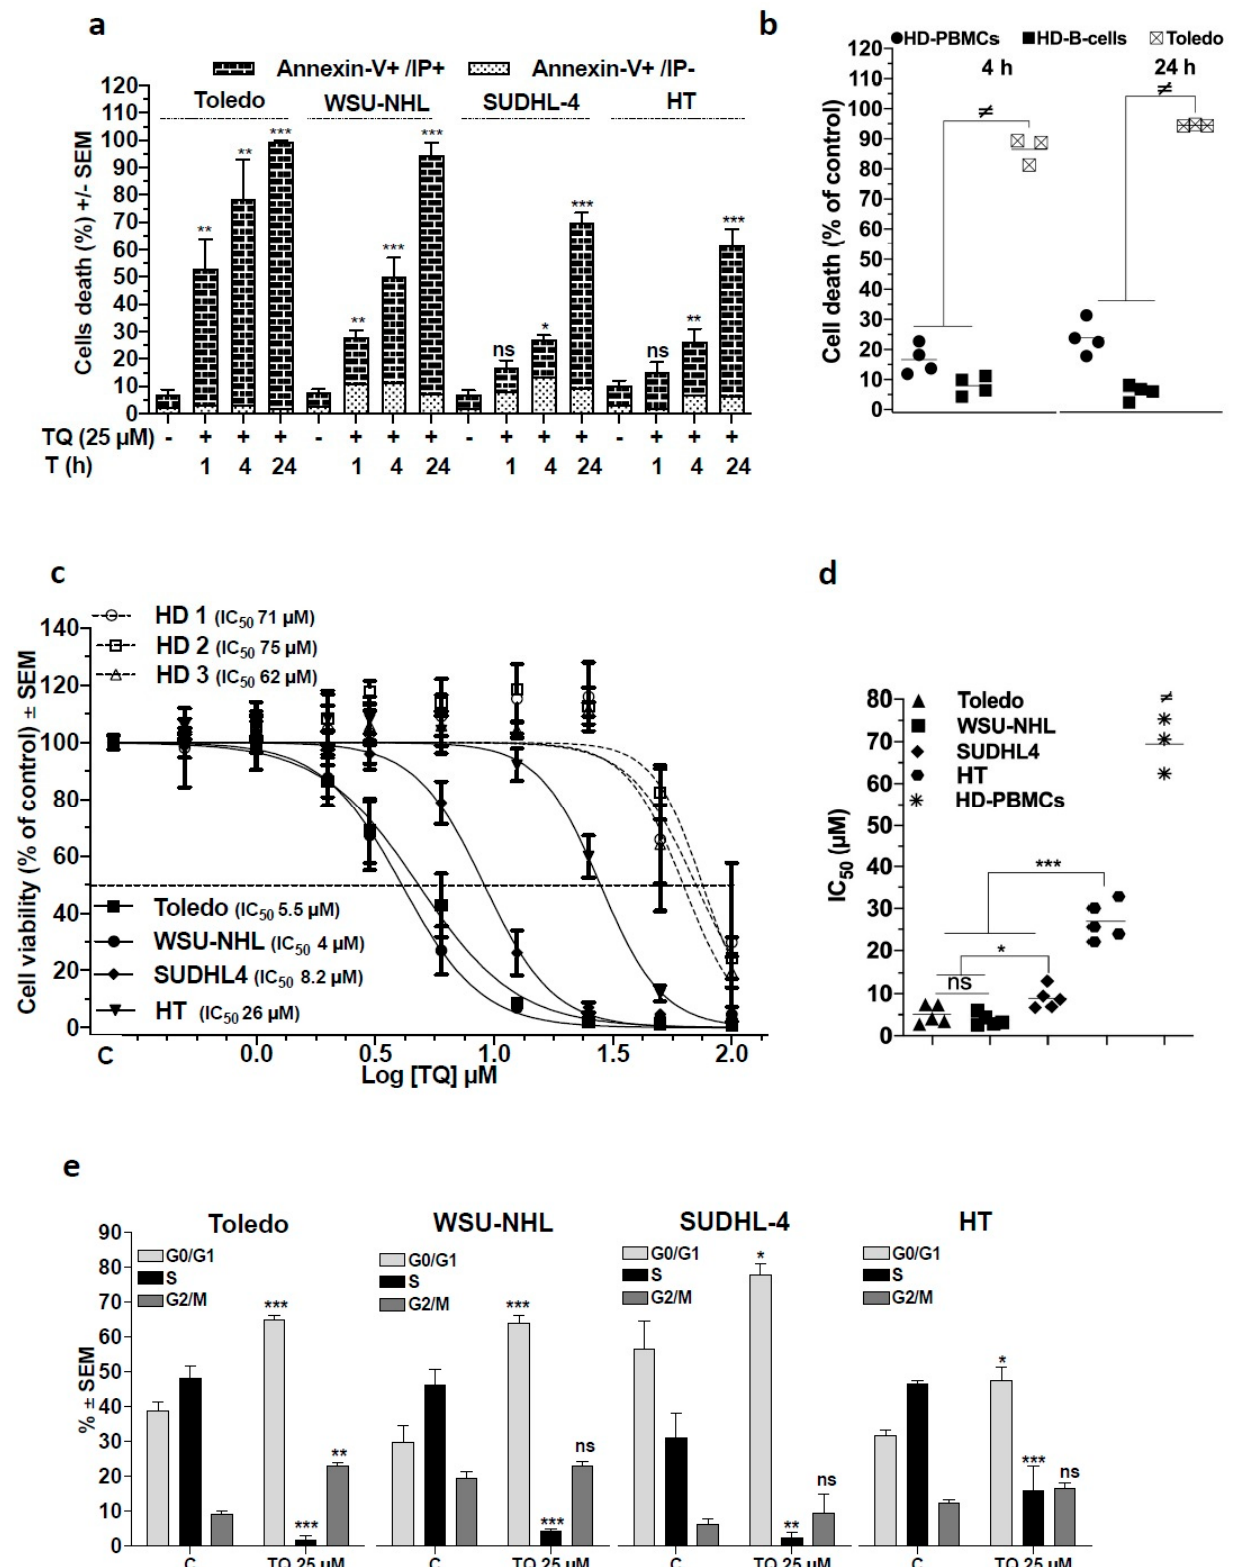
Figure 1. Effect of thymoquinone (TQ) on cell death and cell proliferation of GCB-DLBCL cell lines Toledo, WSU-NHL, SUDHL-4, and HT, and healthy hematological cells. ( a , b ) Cell death analysis: Cells were incubated in the presence of the drug vehicle (DMSO) or thymoquinone (TQ), then cell death was analyzed via flow cytometry after Annexin-V-FTIC/PI staining. Dead cells were identified as Annexin-V-FITC- and PI-positive cells. ( a ) Data are the mean of at least three